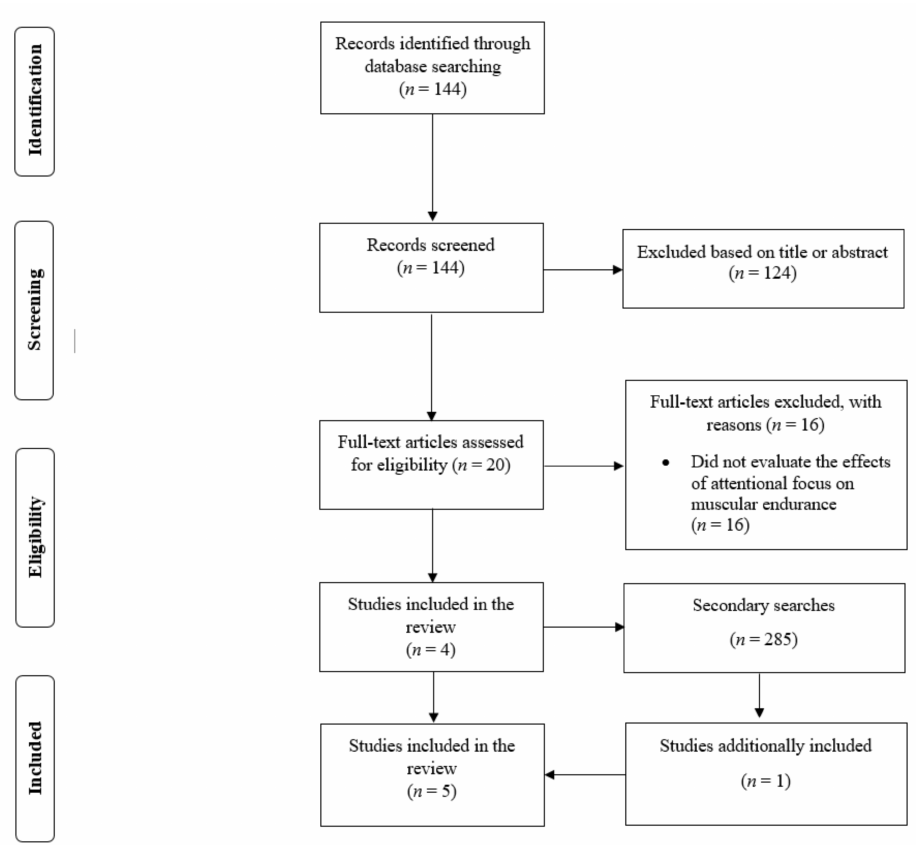
Figure 1. Depiction of the search